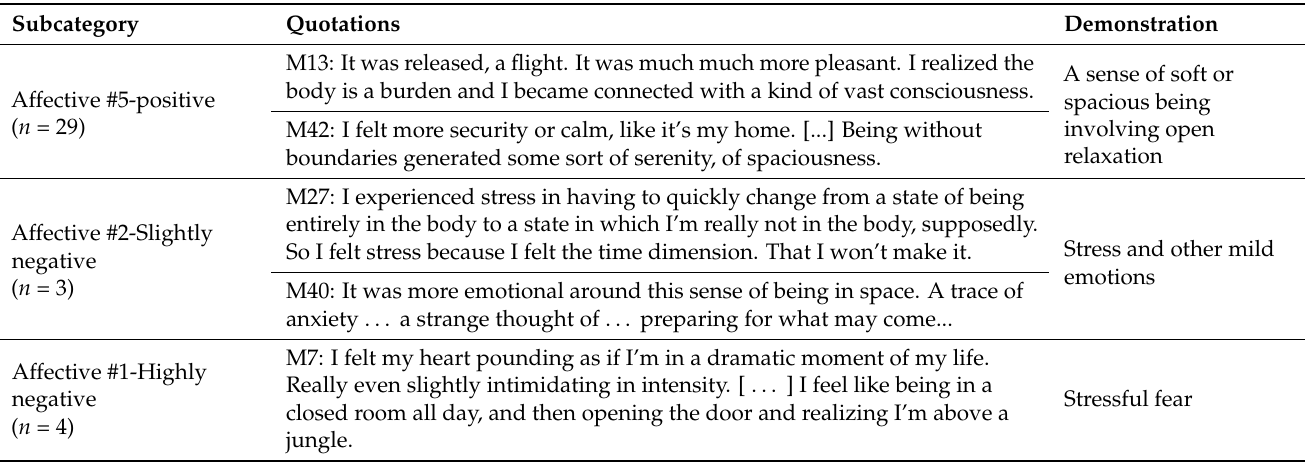
Table 11. SB − representative examples of affective